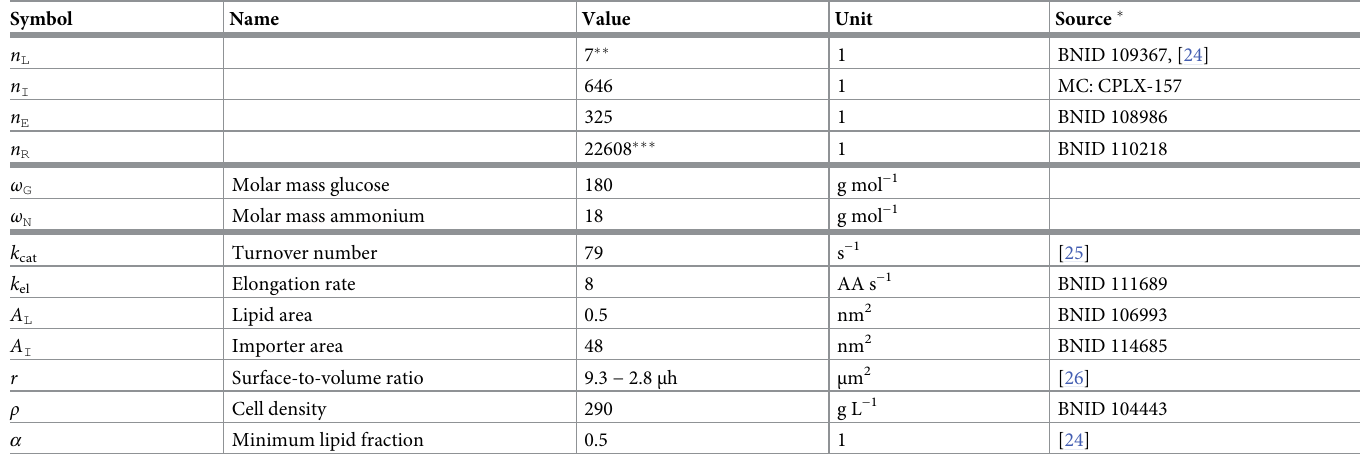
Table 2. Parameter values for the small model of a self-fabricating